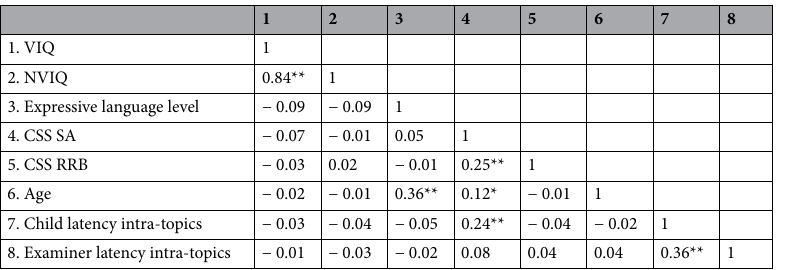
Table 1. Bivariate correlations between clinical measures and intra-topic latency. N = 333–350. * p < 0.05, ** p <